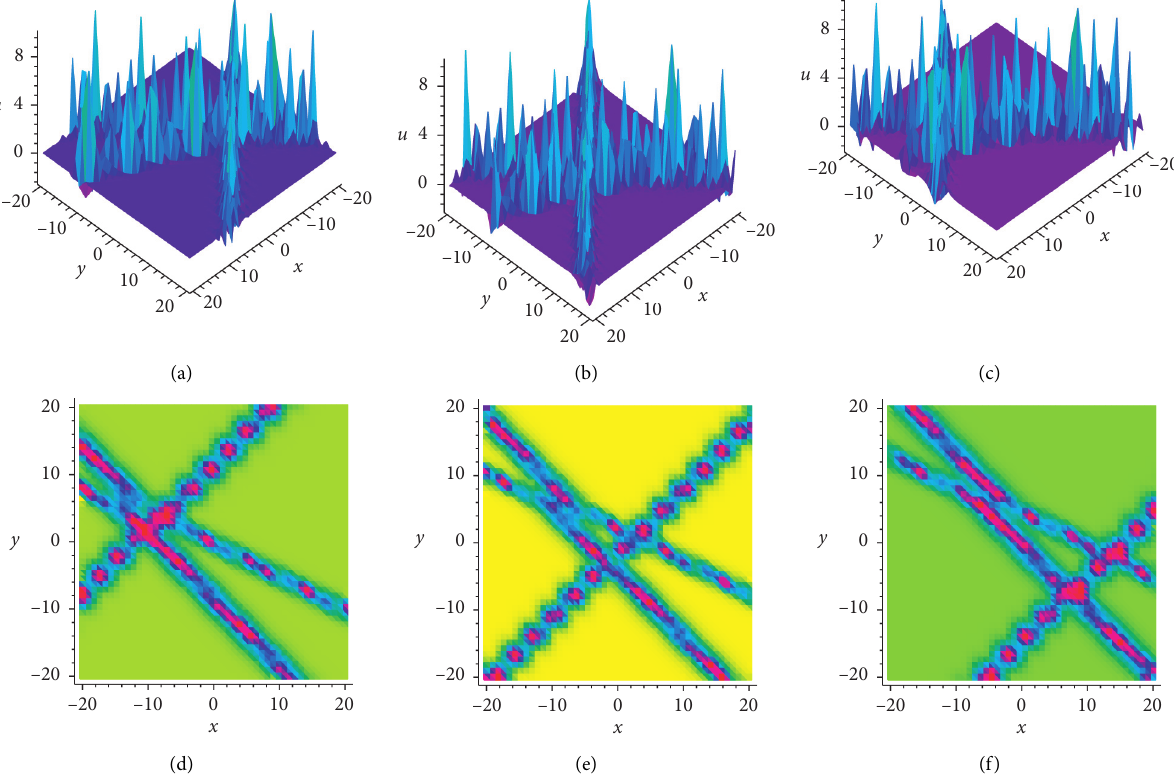
Figure 5: Evolution graphs of the third-order breather solution: (a), (b), and (c) are the three-dimensional plots at t � − ( 1/2 ) , t � 0, and t � ( 1/2 ) , and (d), (e), and (f) are the corresponding density plots at t � − ( 1/2 ) , t � 0, and t � ( 1/2 )